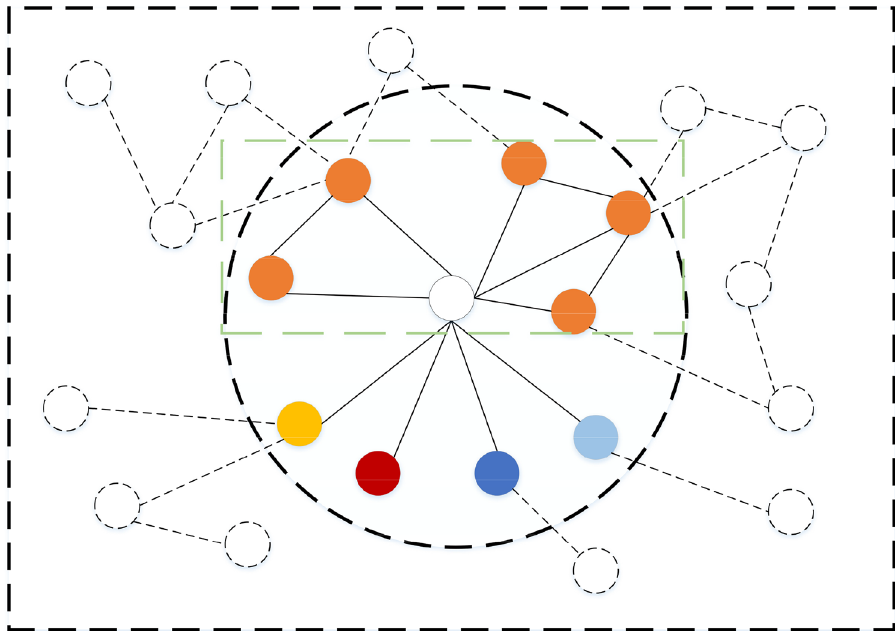
Figure 3. The color of the node represents the label feature information of the node. The central node completes a convolution operation by aggregating the first-order neighbor information. After each convolution operation, the central node completes its own feature update operation, and the updated feature matrix is used as the input of the next